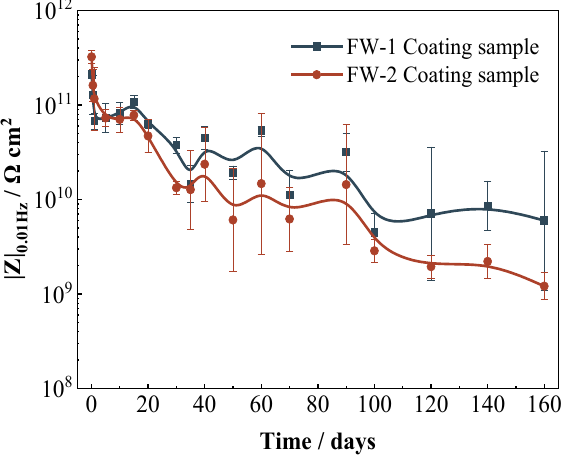
Figure 6. Variation of | Z | 0.01 Hz for two coating samples with time.